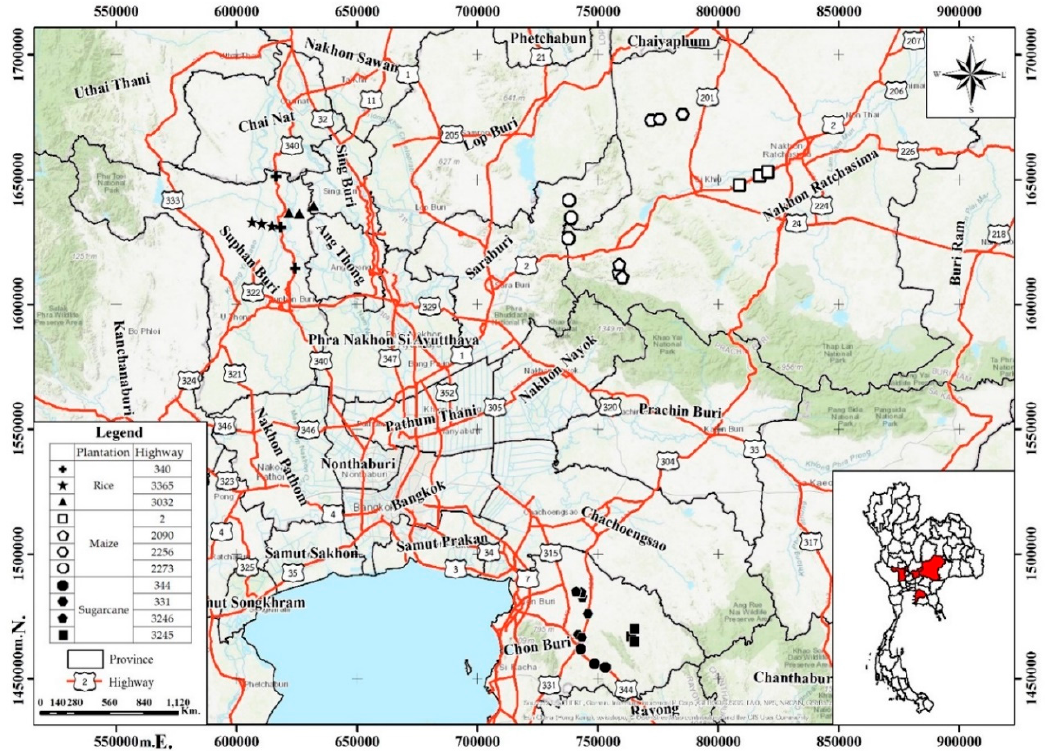
Figure 1. Sampling sites of roadside agricultural soils from central, northeastern and eastern Thailand.